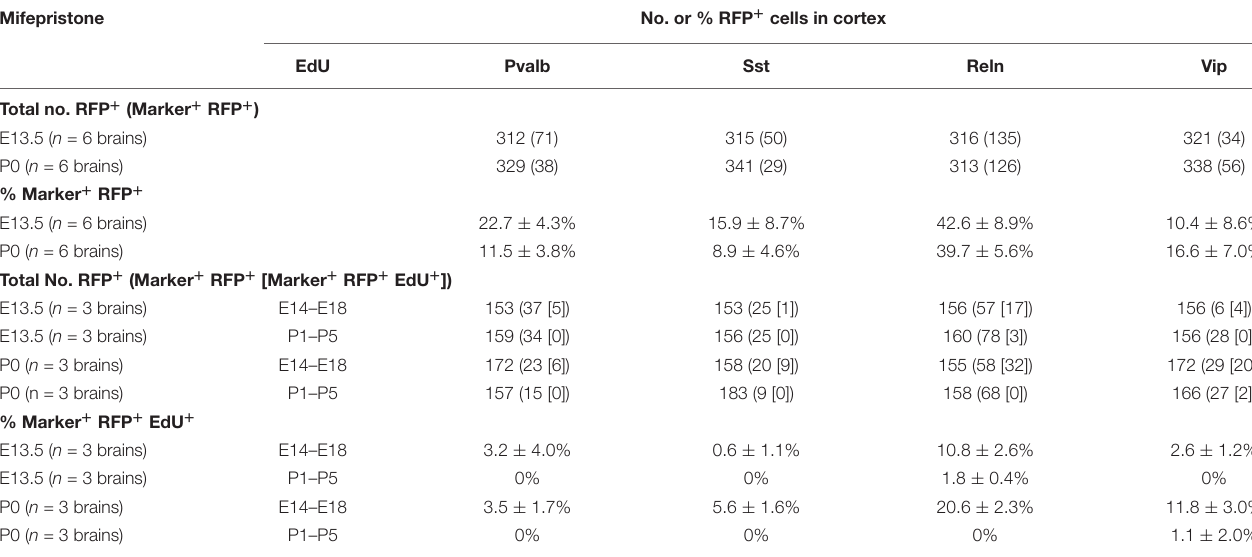
TABLE 3 | Percentages of TdTomato + cells labeled with EdU and/or GABAergic neuron markers. Mifepristone No. or % RFP + cells in